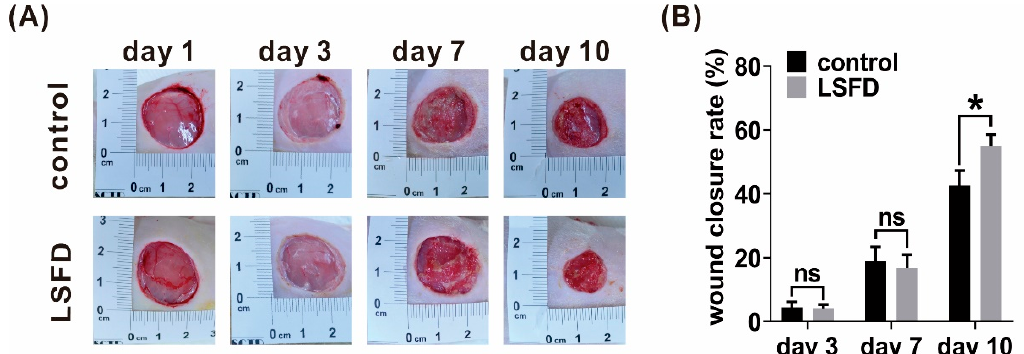
Figure 2. In vivo wound repair evaluation of β -sheet lyophilized silk fibroin dressing (LSFD)-treated burn injuries in rats. ( A ) The photographic appearance of burn wounds in β -sheet LSFD and control groups on day 1, 3, 7, and 10 post-wounding. All animals received wound debridement on day 1. ( B ) Quantitative representation of the wound closure rate. Data are presented as the mean ± standard error of the mean ( n = 7; * p < 0.05, ns: not significant).